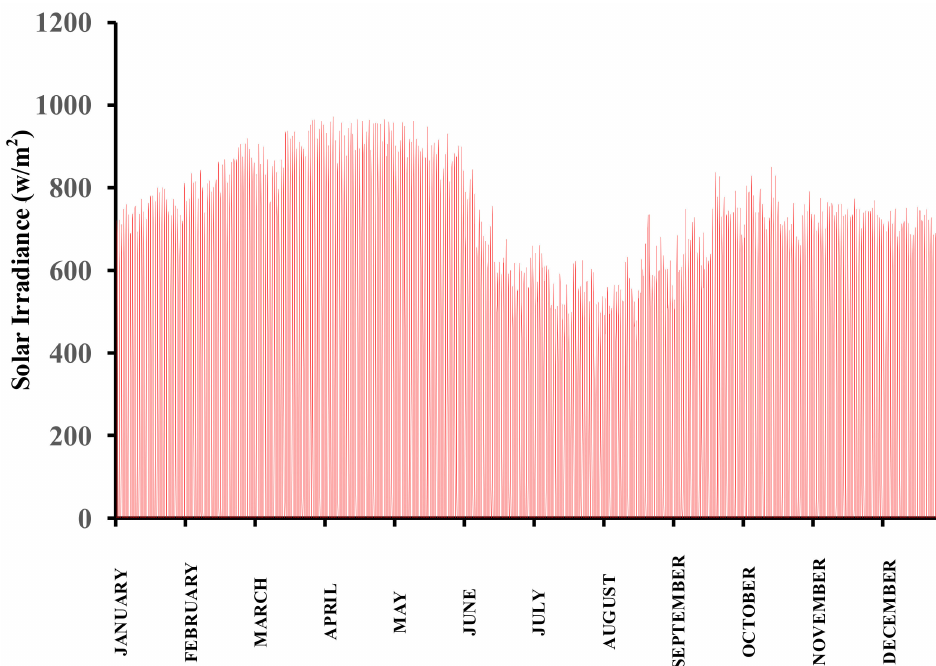
Figure 5. Annual global solar radiation of the study area.